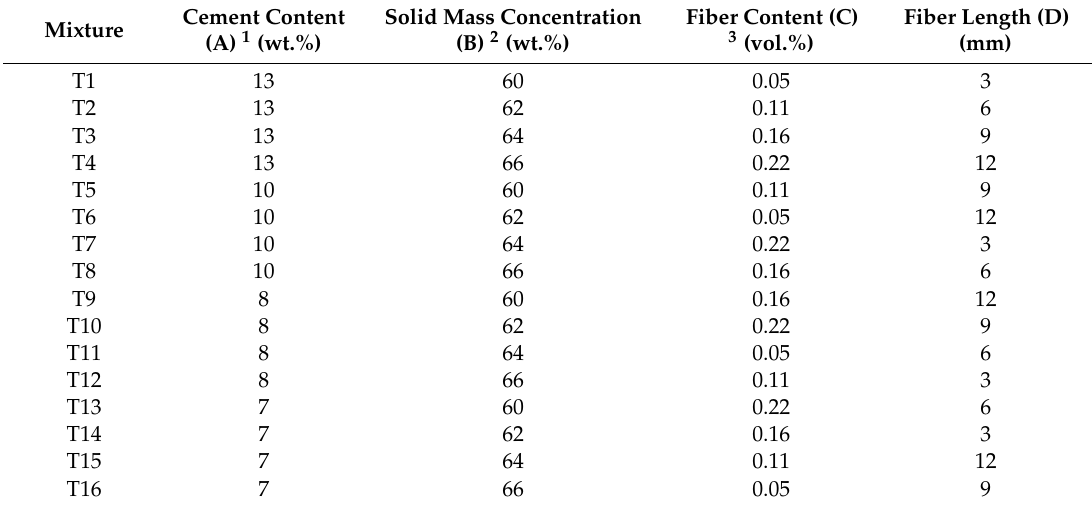
Table 2. Orthogonal table of L 16 (4 4 ) for experiment design.